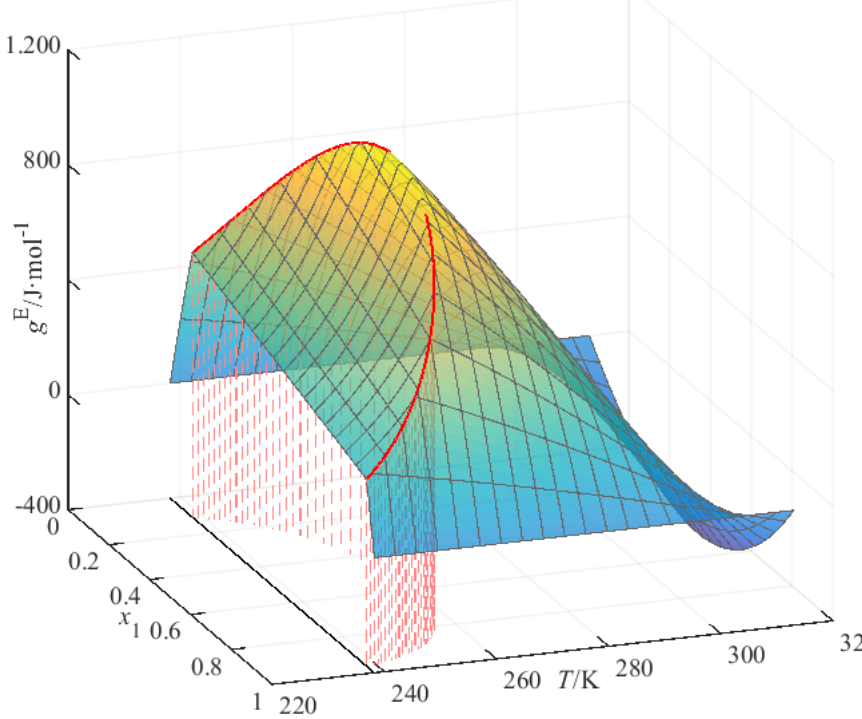
Figure 4. Plot of g E = g E ( p , T ,x) using the NRTL model and the APV88 parametrization. Projection on the T vs x 1 plane corresponding to the geometric place of the LLE compositions is included.